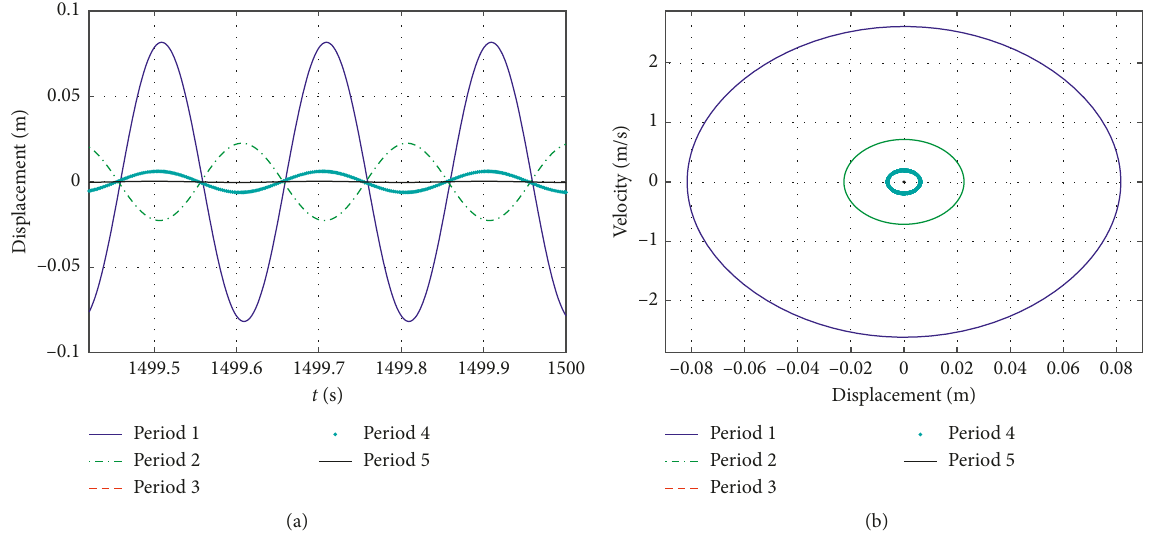
Figure 11: Five periodic shells’ (a) displacement time history curves and (b) phase